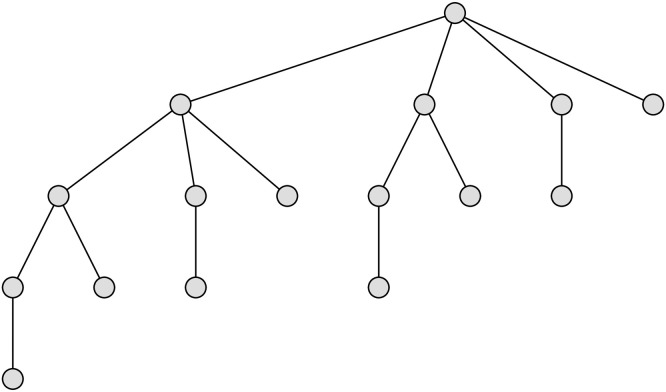
A complete trie for σ = 4.